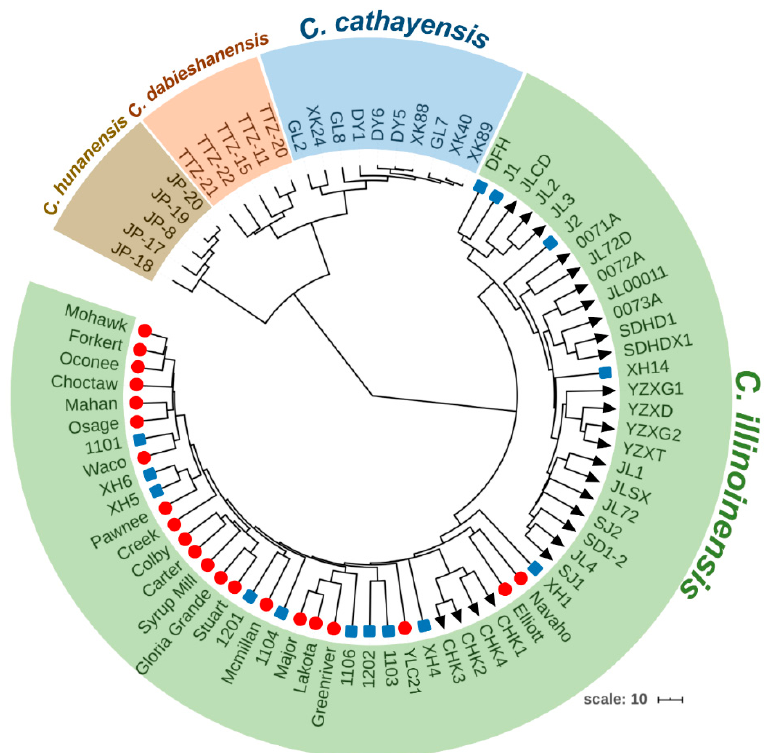
Figure 4. The dendrogram of 80 germplasms constructed by the unweighted pair group method with arithmetic average (UPGMA). The plant samples included 60 C. illinoinensis , 10 C. cathayensis , five C. dabieshanensis , and five C. hunanensis . The positions of cultivars, strains, and seeding plants of pecan are indicated by red circles, blue squares, and black triangles.